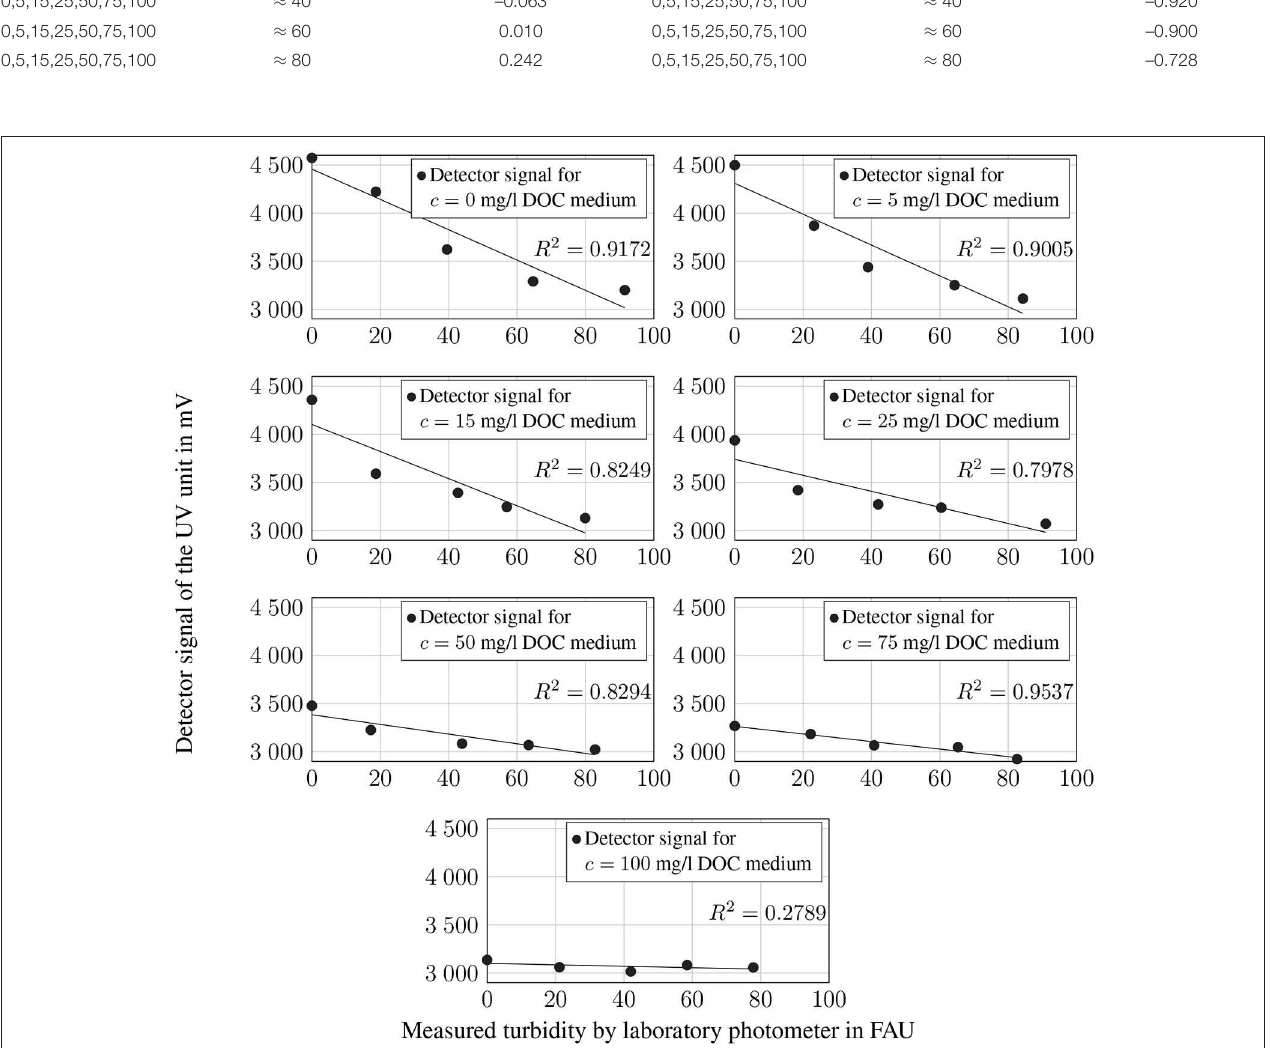
FIGURE 6 | Measured detector signals of the UV sensor in mV for all DOC concentrations and different turbidity values in comparison to the values determined by laboratory photometers. The trend line was generated by linear regression.